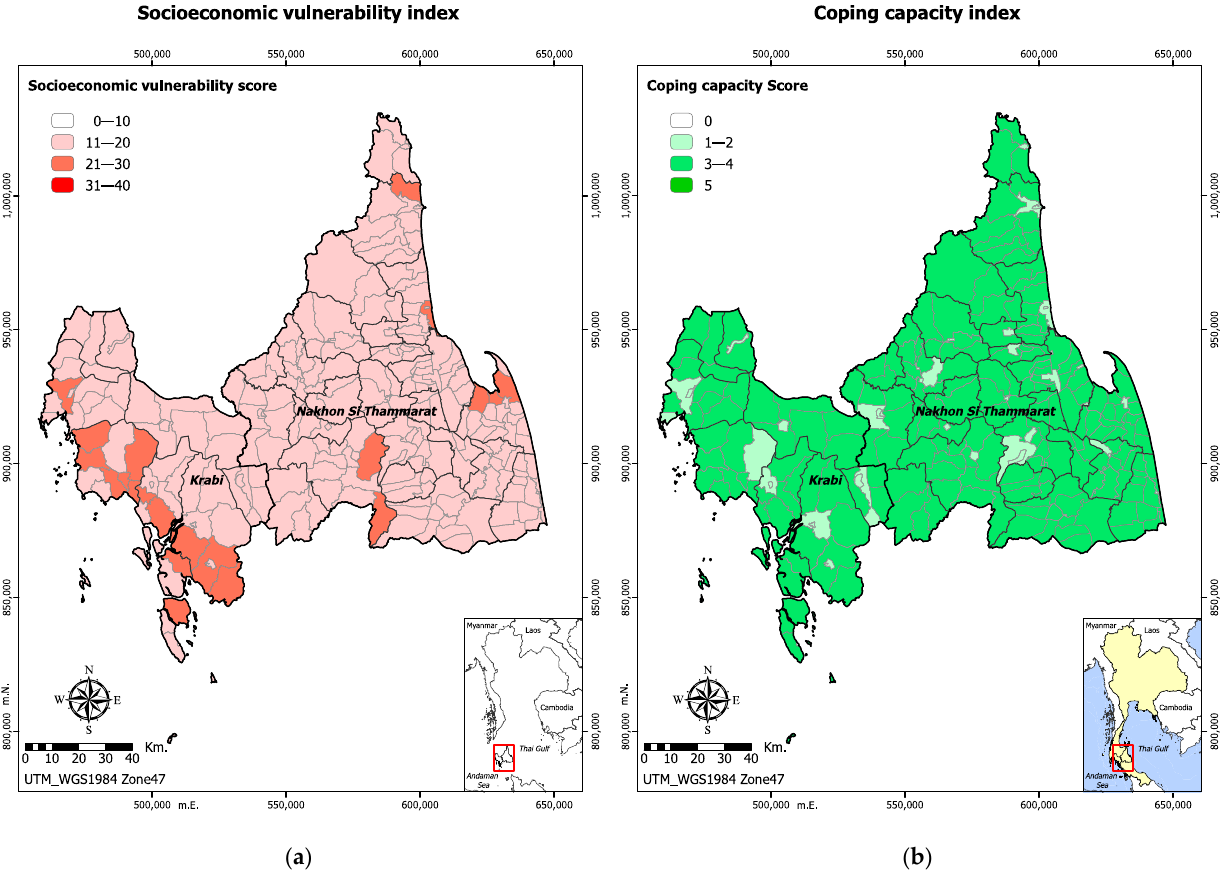
Figure 5. Resilience to natural hazards: ( a ) socio-economic vulnerability index; ( b ) coping capacity